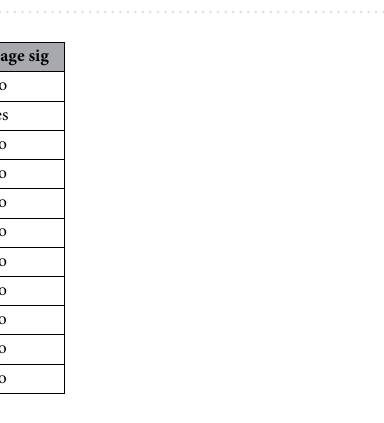
Table 3. Results of lasso analysis of m5C regulatory